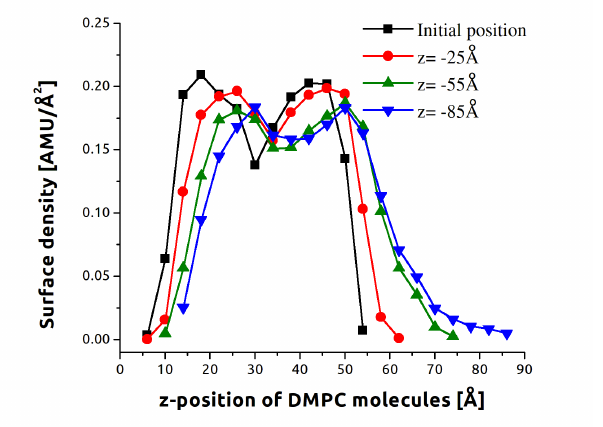
Figure 3. The average DMPC mass density profile along the z -axis. Data are for the SiCNT indenter at 2 m/s, a 15 ◦ angle z -axis indentation. Each point represents a 4 Å wide average across all equivalent trajectories for the instant specified in the inset. Table 1 quantifies the relative disruption of the membrane by the average (standard deviation) of lipids removed for each case. SiCNT removed the most lipids on average and the highest number of lipids in a single trajectory (19 lipids) during one z -axis indentation run. In all cases, indenters at greater angles removed more lipids and in all but a single case (CNT at 15 ◦ along the z -axis), faster indentation resulted in membrane